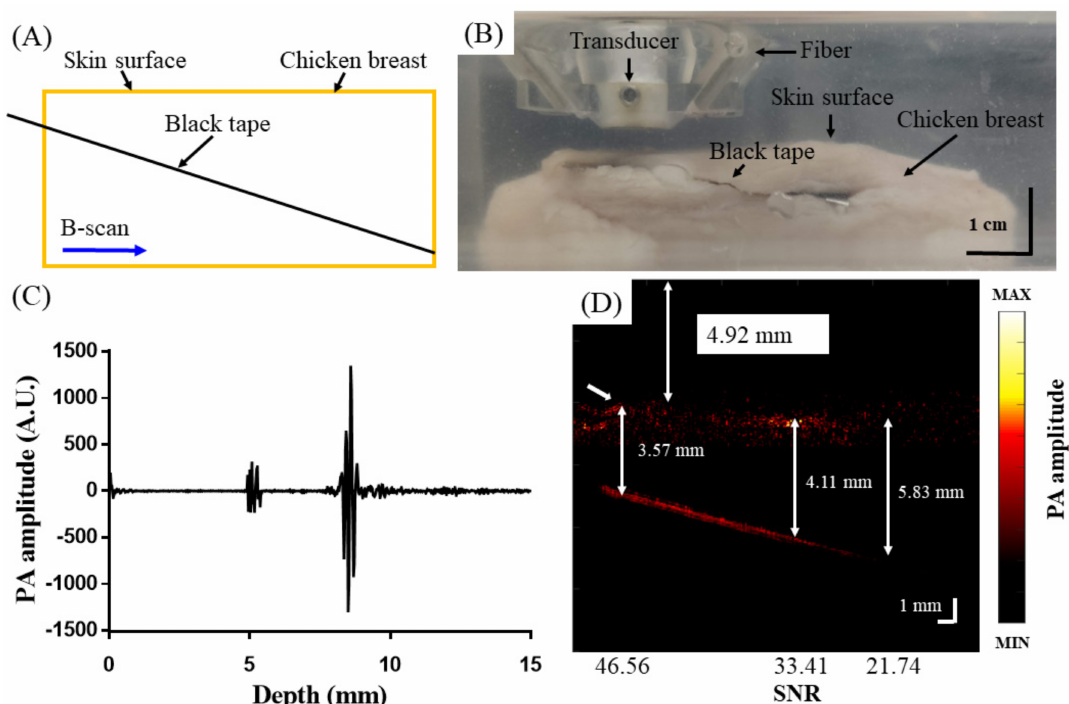
Figure 9. Testing the performance of the AR − PAM probe by imaging a black piece of tape obliquely inserted into chicken breast tissue. ( A ) Experimental setup; ( B ) representative image of the experimental setup; ( C ) PA A − scan signal; ( D ) PA B − scan